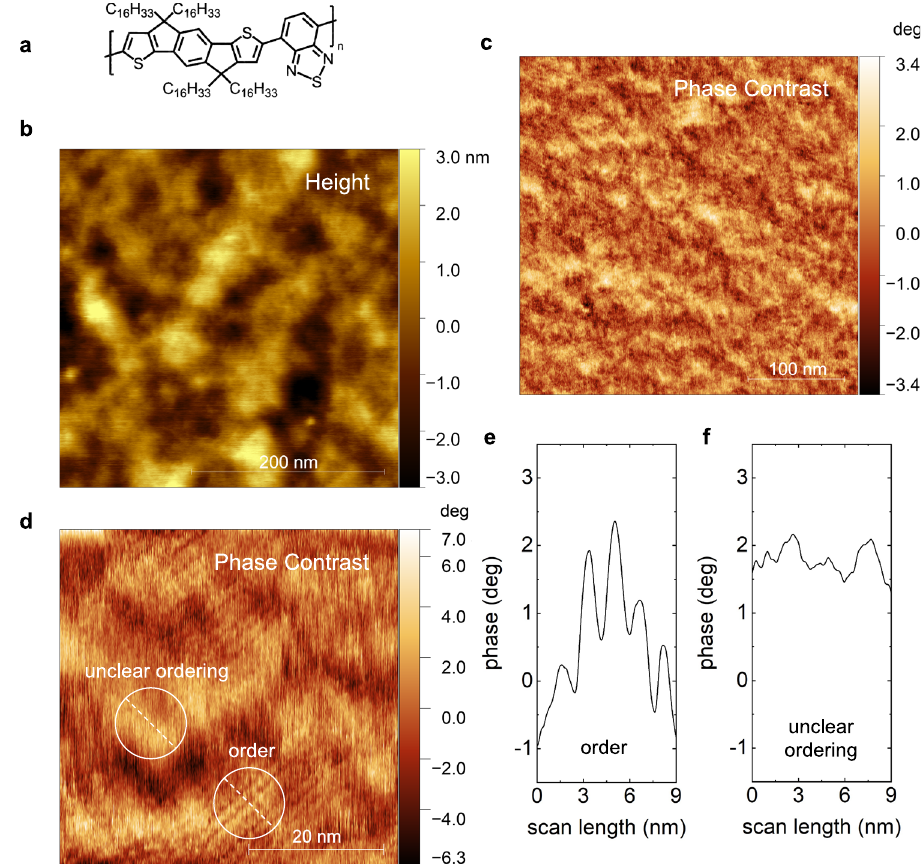
Fig. 1 Nanostructure of C16-IDTBT fi lms. a Chemical structure of a C16-IDTBT monomer showing its fused donor molecular unit (IDT) and its acceptor molecular unit (BT). b Height topography of a C16-IDTBT spin-coated thin fi lm. c Corresponding phase contrast image of the C16-IDTBT thin fi lm on the scale of hundreds of nanometers. d Phase contrast image on the scale of tens of nanometers demonstrating regions of order 10 – 15 nm across and regions of unclear ordering within tens of nanometers from the ordered regions. e Line scan along the dashed straight lines of (d) in the ordered region. f Line scan along the dashed straight line of (d) in the region of unclear order. The distance between the parallel polymer backbone fi laments of (d) is ~1.6 nm and is smaller than that expected for in-plane sidechain